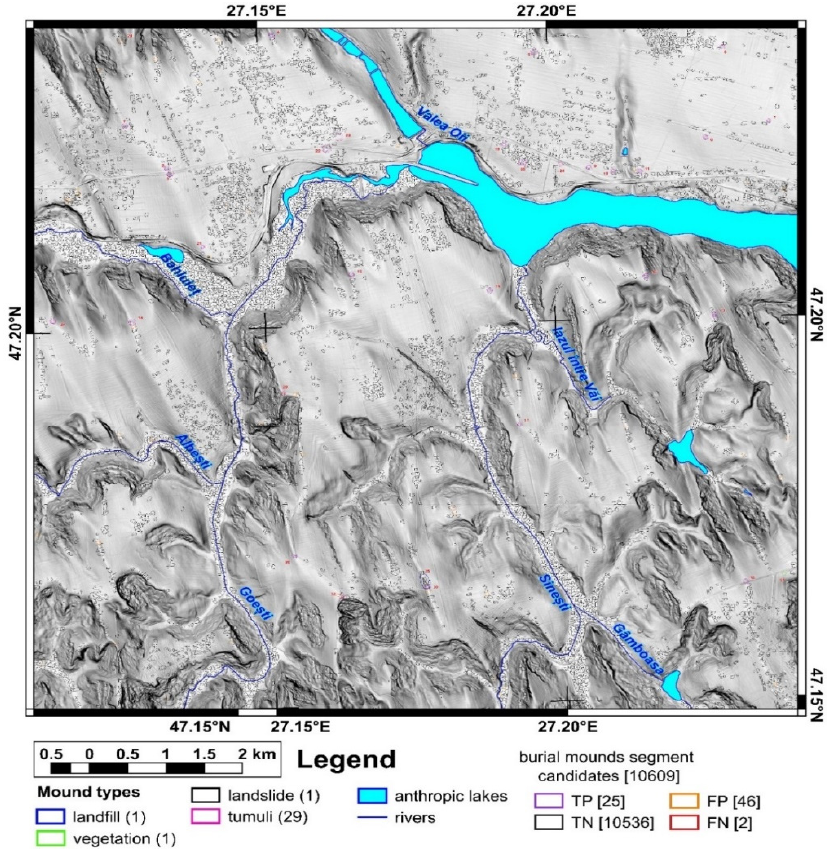
Figure 18. The burial mounds local convexity watershed segments candidates for the validation (southern) study area. (a high-resolution version can be found at https://doi.org/10.6084/m9.figshare.11798697.v1)